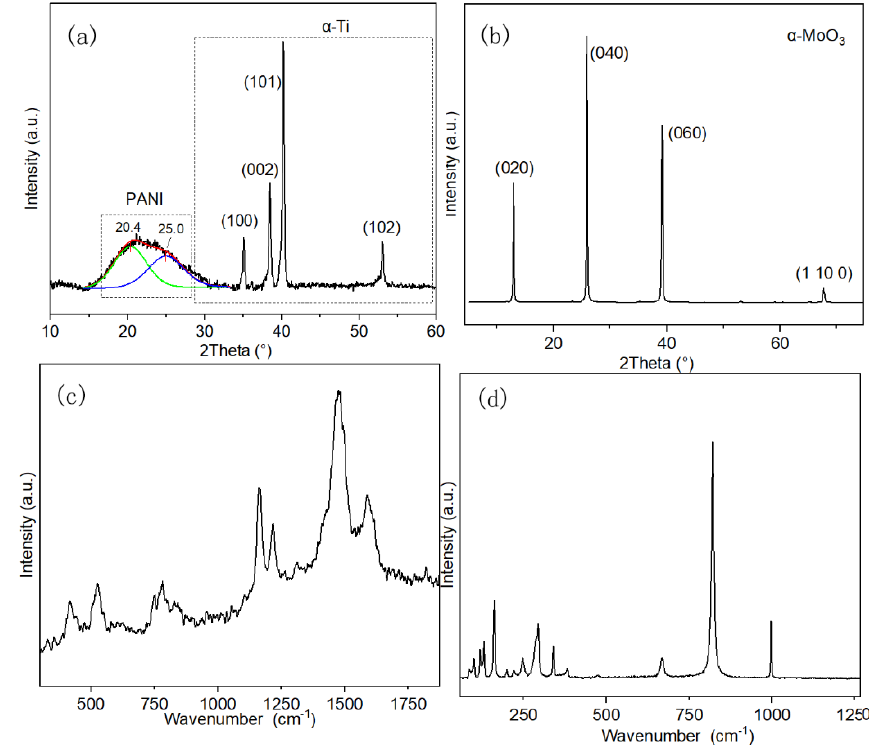
Figure 2. X-ray di ff raction (XRD) spectra of PANI / Ti composite ( a ) and MoO 3 ( b ); Raman spectra of Figure 2. X-ray diffraction (XRD) spectra of PANI/Ti composite ( a ) and MoO 3 ( b ); Raman spectra of PANI ( c ); and, MoO 3 ( d PANI ( c ); and, MoO 3 ( d ).